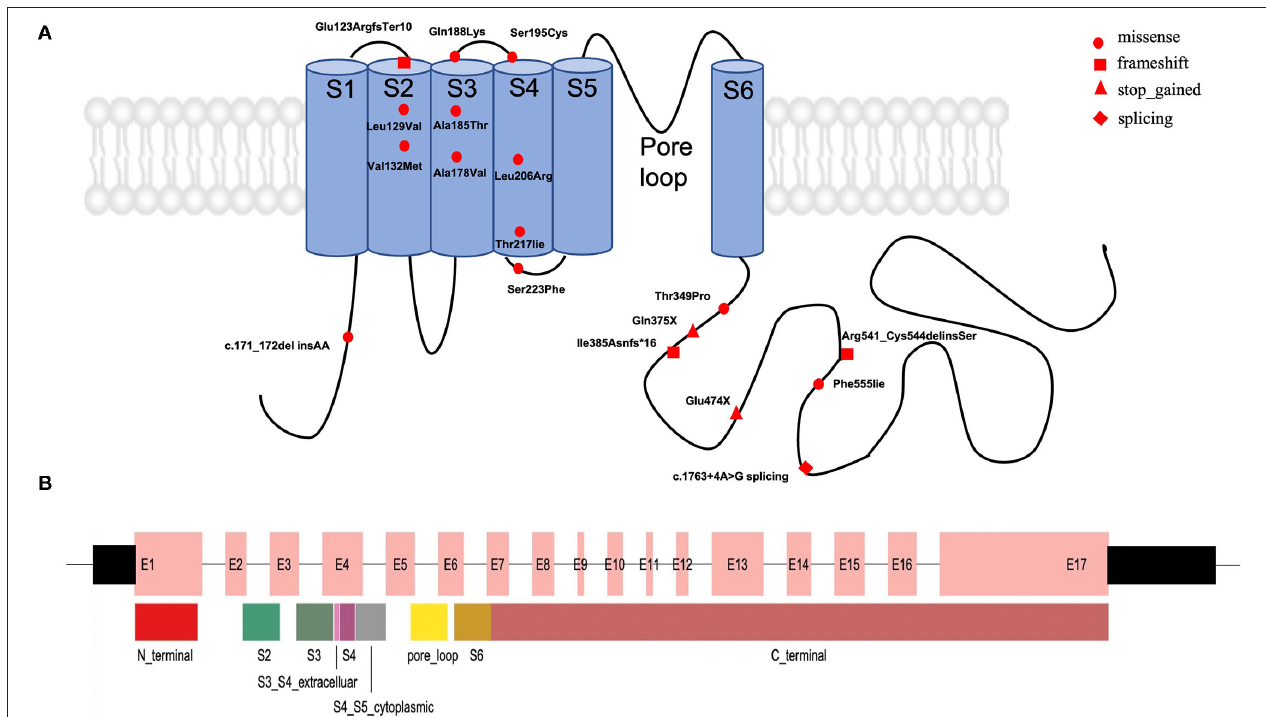
FIGURE 1 | The distribution of the 19 novel variations in the KCNQ2 gene. (A) Approximate locations of the 19 novel KCNQ2 variants. KCNQ2 protein has six transmembrane domains (blue). The fourth segment acts as the voltage sensor, and the loop between the fifth and sixth domains forms the ion pore in the Kv7.2 potassium channel. (B) The distribution of exons and protein domain in the KCNQ2 gene. The wide box represents the coding region in the 17 exons. S1: segment S1, S2: segment S2, S3: segment S3, S4: segment S4, S5: segment S5, S6: segment S6, S3_S4_extracelluar: the extracellular region between segment S3 and segment S4; S4_S5_cytoplasmic: the cytoplasmic region between segment S4 and segment S5; pore_loop: the loop between the fifth and sixth domains forms the ion pore in a K7.2 potassium